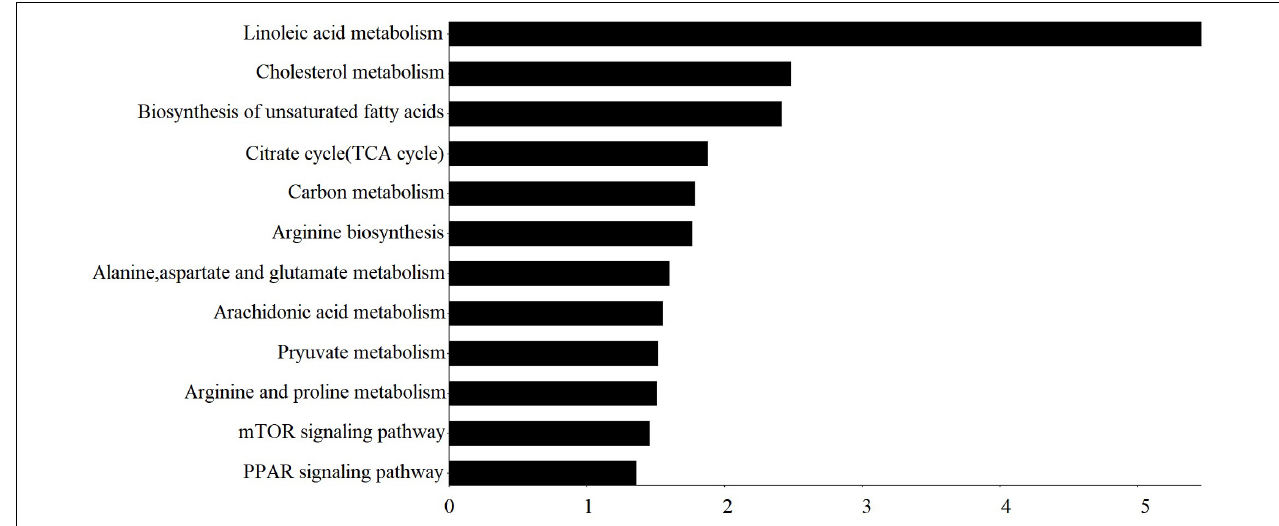
FIGURE 2 | Important KEGG pathway terms ( p < 0.05) enriched by differential metabolites (DMs) in subcutaneous fat of FYs and MYs. The X -axis means –log 10 P. The Y -axis represents the KEGG pathway terms.